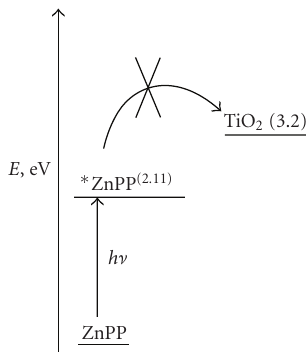
Figure 3: Steady state fluorescence quenching of ZnPP (2 × 10 − 6 M) with colloidal TiO 2 in the concentration range of (0–5) × 10 − 4 M in water.